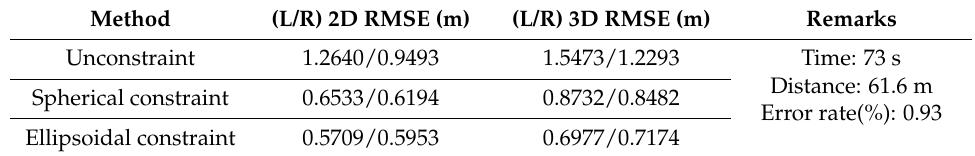
Figure 5. Left and right feet altitude difference in 2D the closed path experiment. ( a ) the height difference of the two feet without contraint; ( b ) the height difference of the two feet with spherical constraint; ( c ) the height difference of the two feet with ellipsoidal constraint. Table 2. RMSE deduction by using the ellipsoidal constraint method for a closed path test.